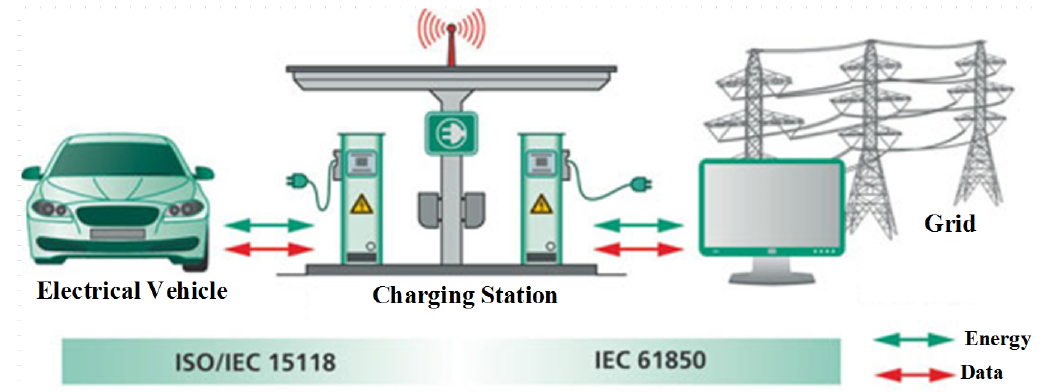
Figure 19. Sample communication standard of the vehicles using V2G technology.